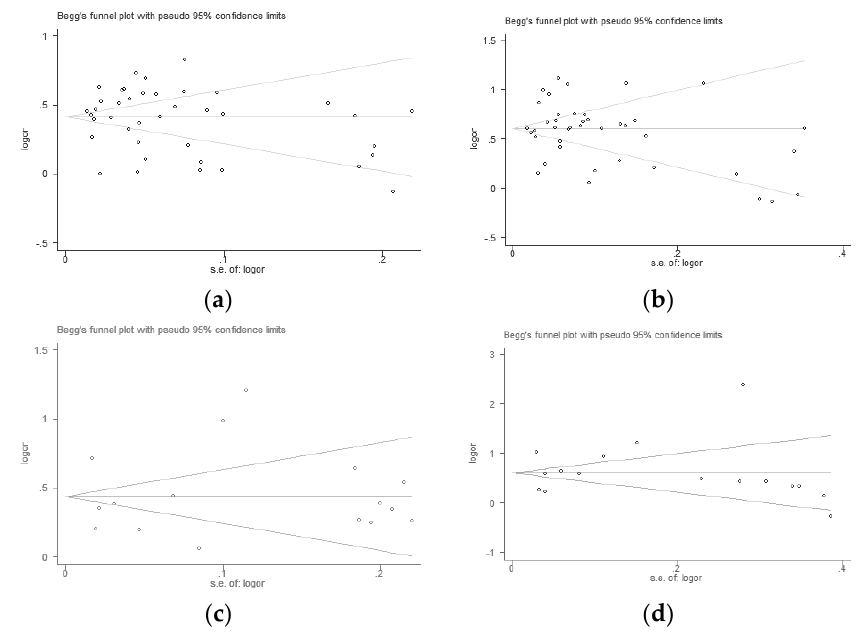
Figure 6. Publication bias in overweight and obesity.